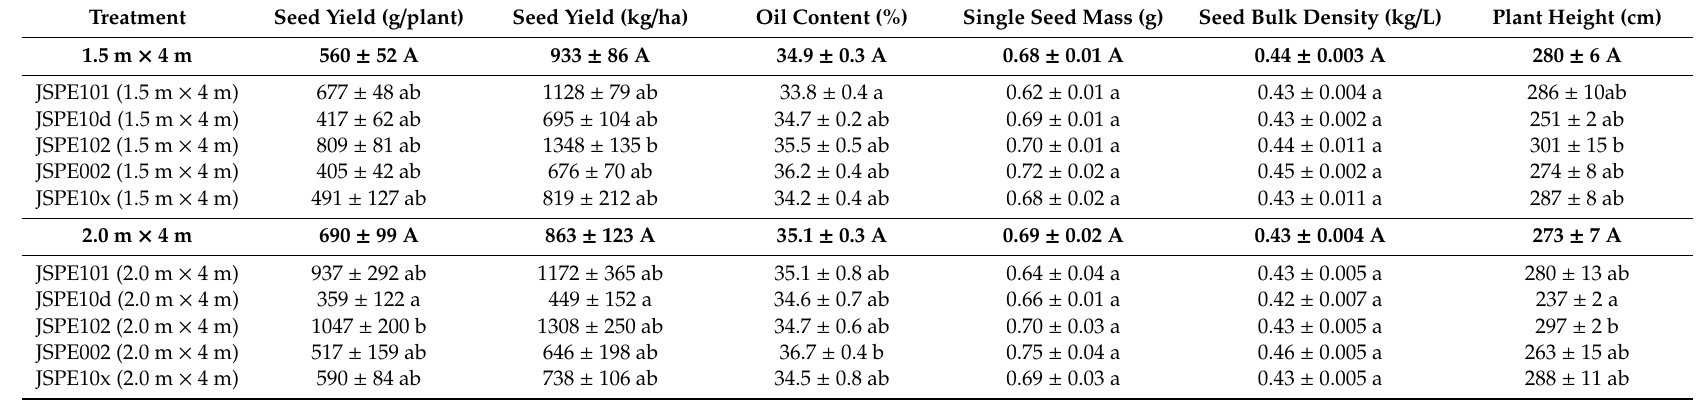
Table 4. Means ± standard errors at Batchenga for spacings averaged over all half sib families (in bold) and per half sib family in the corresponding spacing (3rd year). Di ff erent capital and small letters, respectively, indicate significant di ff erences at α =